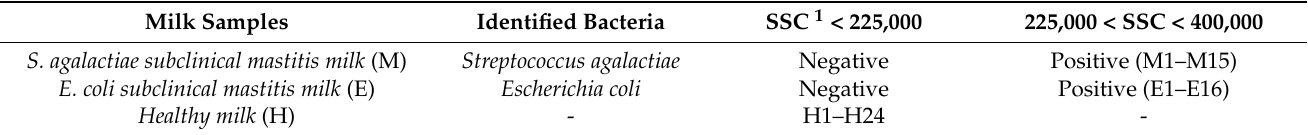
Table 1. Basic characteristics and classifications of the milk samples (coded) included in this study.